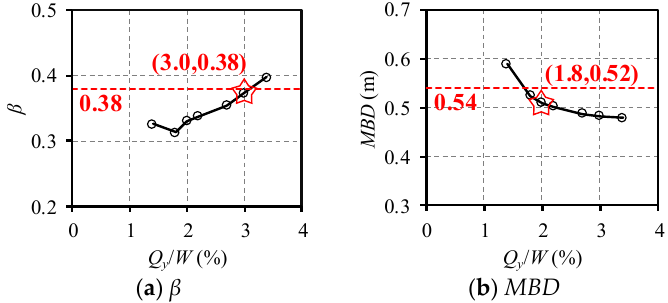
Figure 4. C1 with partially basement ‐ isolated (PBI) scheme.